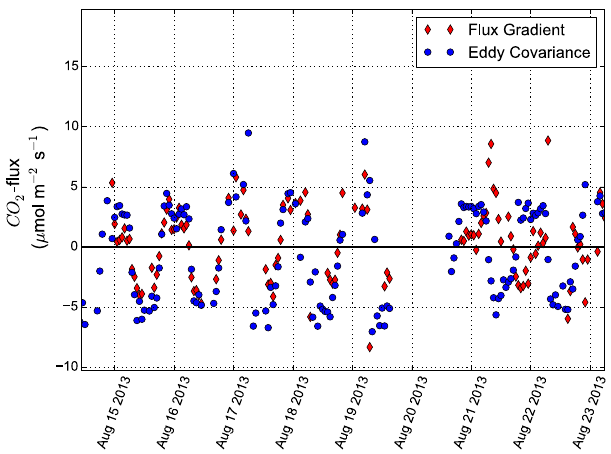
Figure B1. Comparison of Flux Gradient- and Eddy Covariance- CO 2 flux measurements over 8days in August. There was a large rain event on 20